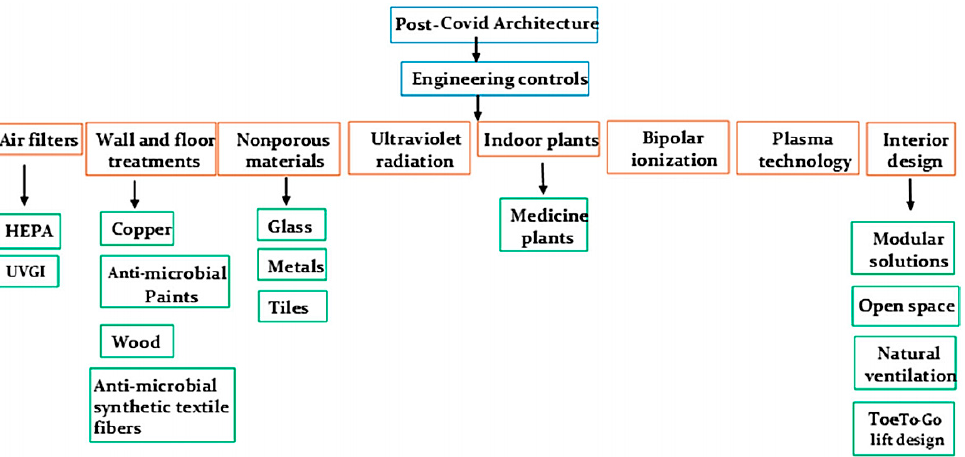
Figure 11. Post-COVID architectural design controls to decrease the COVID-19 disease transmission (Adapted from [102]).